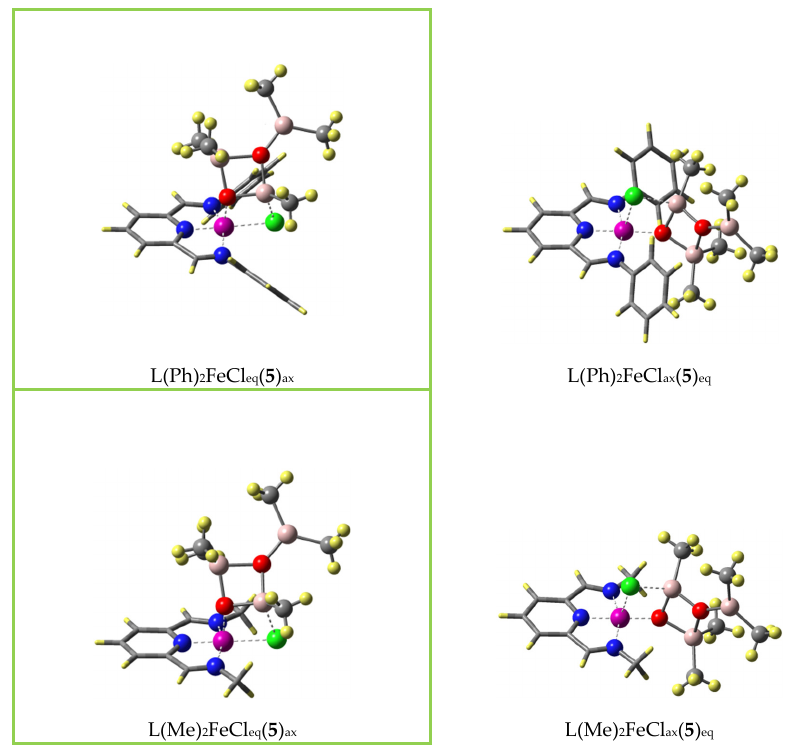
Figure 6. Computed structure of catalyst with 5 , the cyclic isomer of the Sinn trimer. Top row: N , N -diphenyl ligand L; bottom row: N , N -dimethyl ligand L. Left column: equatorial chloride; right column: axial chloride.